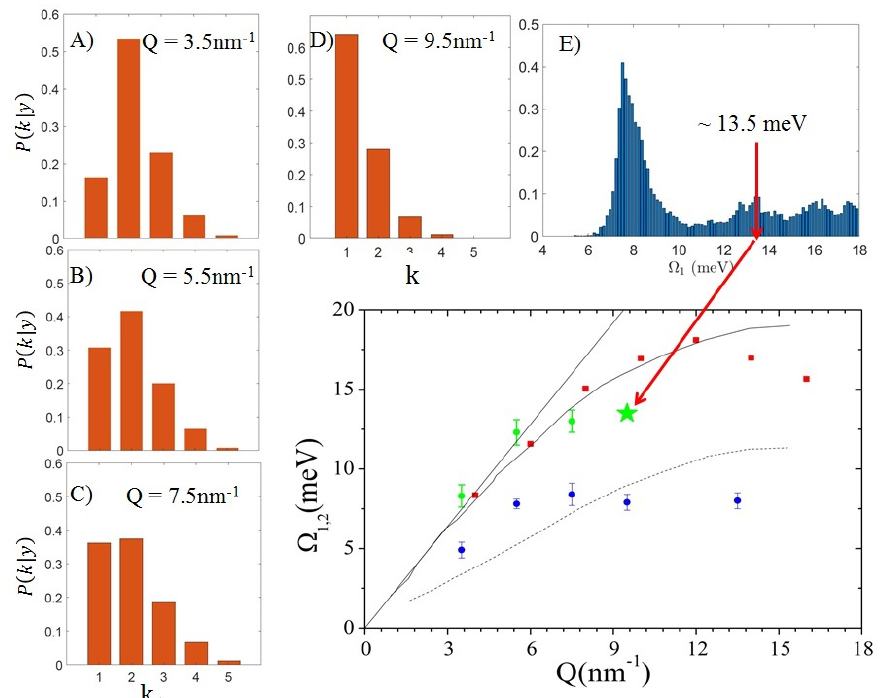
Figure 7. ( A – C ): posterior probability for the number of inelastic modes k for the IXS spectra collected on the NP suspension up to Q = 7.5 nm − 1 ; the same probability for Q = 9.5 nm − 1 is also reported in ( D ), while the posterior distribution P ( Ω 1 | y ) for the excitation frequency corresponding to the most plausible model option at this Q value ( k = 1) is reported in ( E ). Finally, the energy derived from the minor mode of this distribution is inserted as a star in the plot of Figure 6 (see arrow). Adapted with permission from Ref. [19]. Copyright (2018) American Chemical